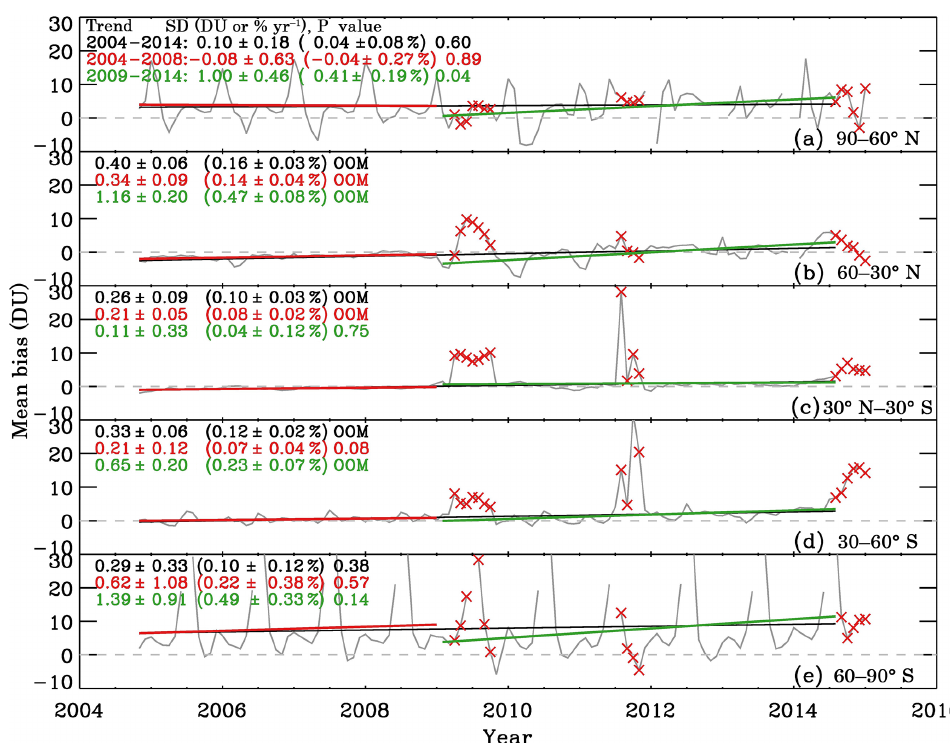
Figure 11. Monthly mean biases of OMI–MLS stratospheric ozone columns with pressure less than 215hPa are plotted in solid gray lines for five different latitude ranges. Extreme small p values are marked as OOM (out of memory). The corresponding linear trends in 2004–2014, 2004–2008, and 2009–2014 are shown in black, red, and green lines, respectively. The red cross signs indicate the periods when OMI has unusually large SOC errors likely due to row anomaly or other unknown issues; the values during these periods are not included in our trend calculations. The legends show linear trends in bothDUyr − 1 and %yr − 1 and the corresponding p